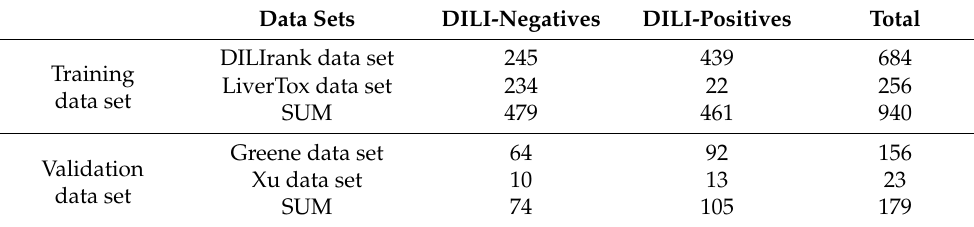
Table 1. Data sets used to generate the drug-induced liver injury (DILI)-prediction model in this study. Data Sets DILI-Negatives DILI-Positives Total DILIrank data set Training data set